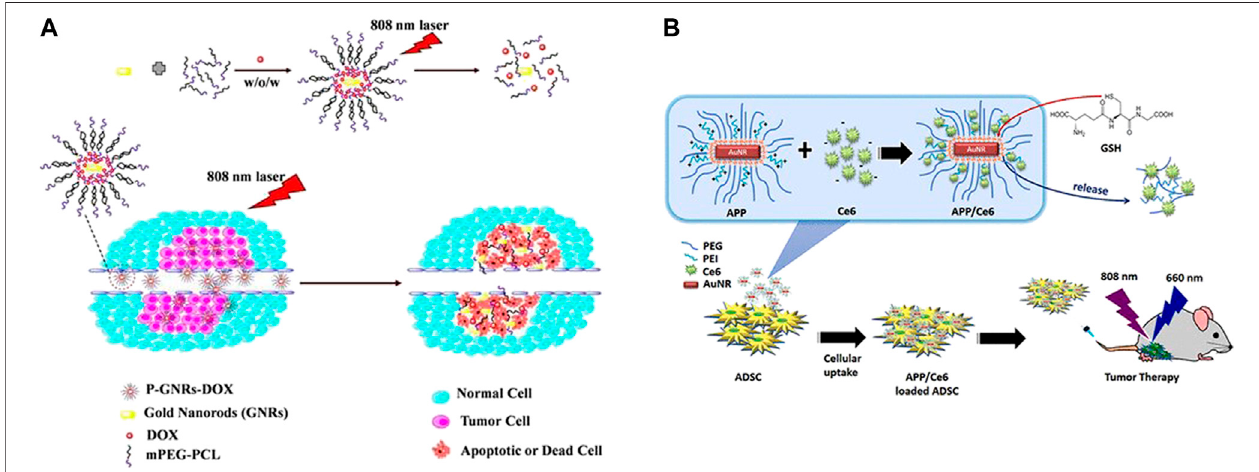
FIGURE 7 | Combination of photothermal therapy and other therapies. (A) The combination of photothermal and chemotherapy using GNRs and doxorubicin co- loaded polymersomes (P-GNRs-DOX) irradiated by 808 nm laser. (Combined Cancer Photothermal-Chemotherapy Based on Doxorubicin/Gold Nanorod-Loaded Polymersomes, http://creativecommons.org/licenses/by-nc-nd/3.0/). (B) The combination of photothermal and photodynamic therapy using AuNR-PEG-PEI (APP)/ chlorin e6 (Ce6)-loaded adipose-derived stem cell (ADSC) system irradiated by 808 nm light for PDT and 660 nm light for PTT. (Chuang et al.,